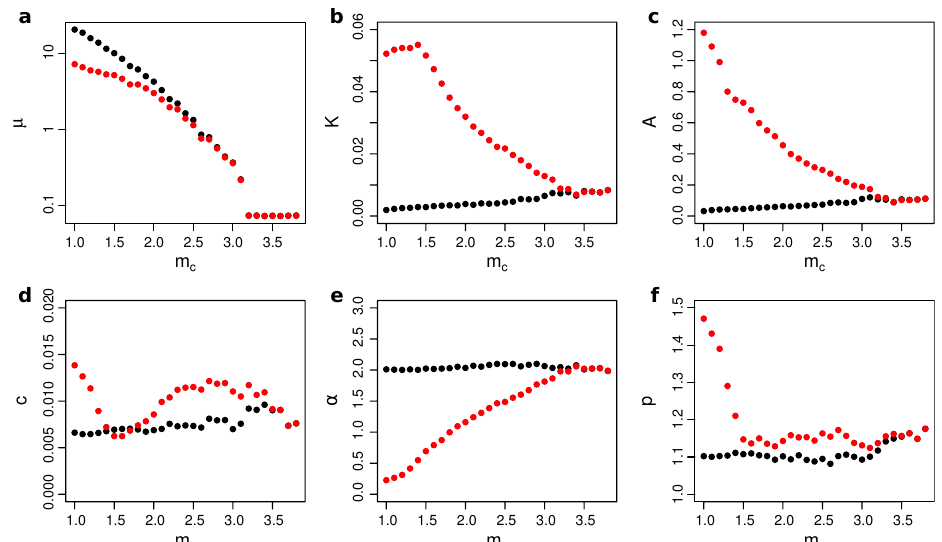
(cid:82) ∞ ( t + c ) − p dt , c , α , p 0